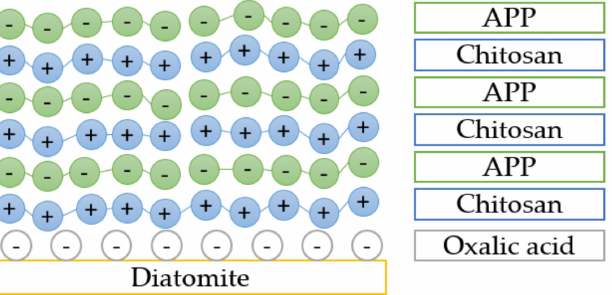
Figure 21. The schematic structure of LbL assembled diatomite based on chitosan and APP